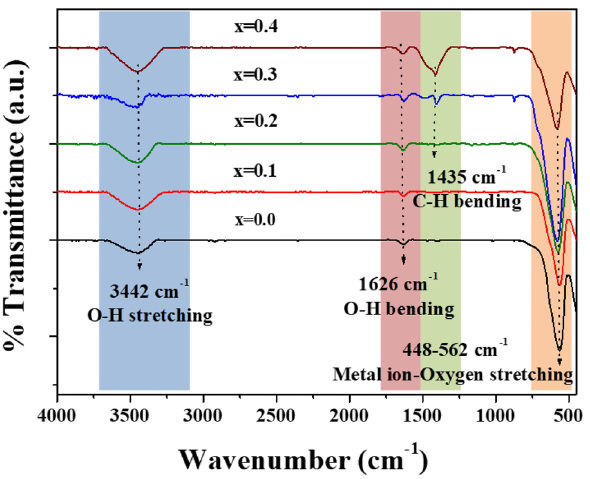
Figure 7. FTIR spectra of Co x Zn 1−x Fe 2 O 4 (x = 0.0–0.4)